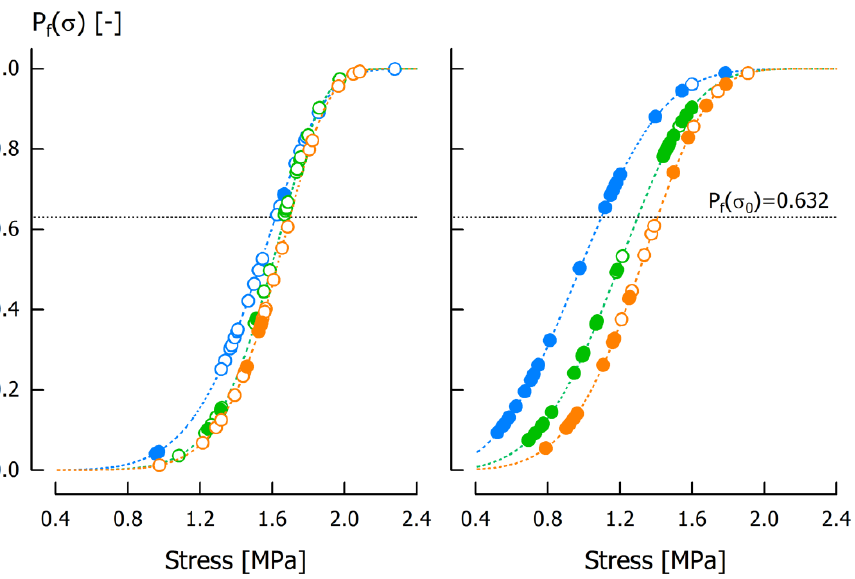
Table 2. Effects of specimen length and tensile velocity on fracture properties ( T = 25 °C).